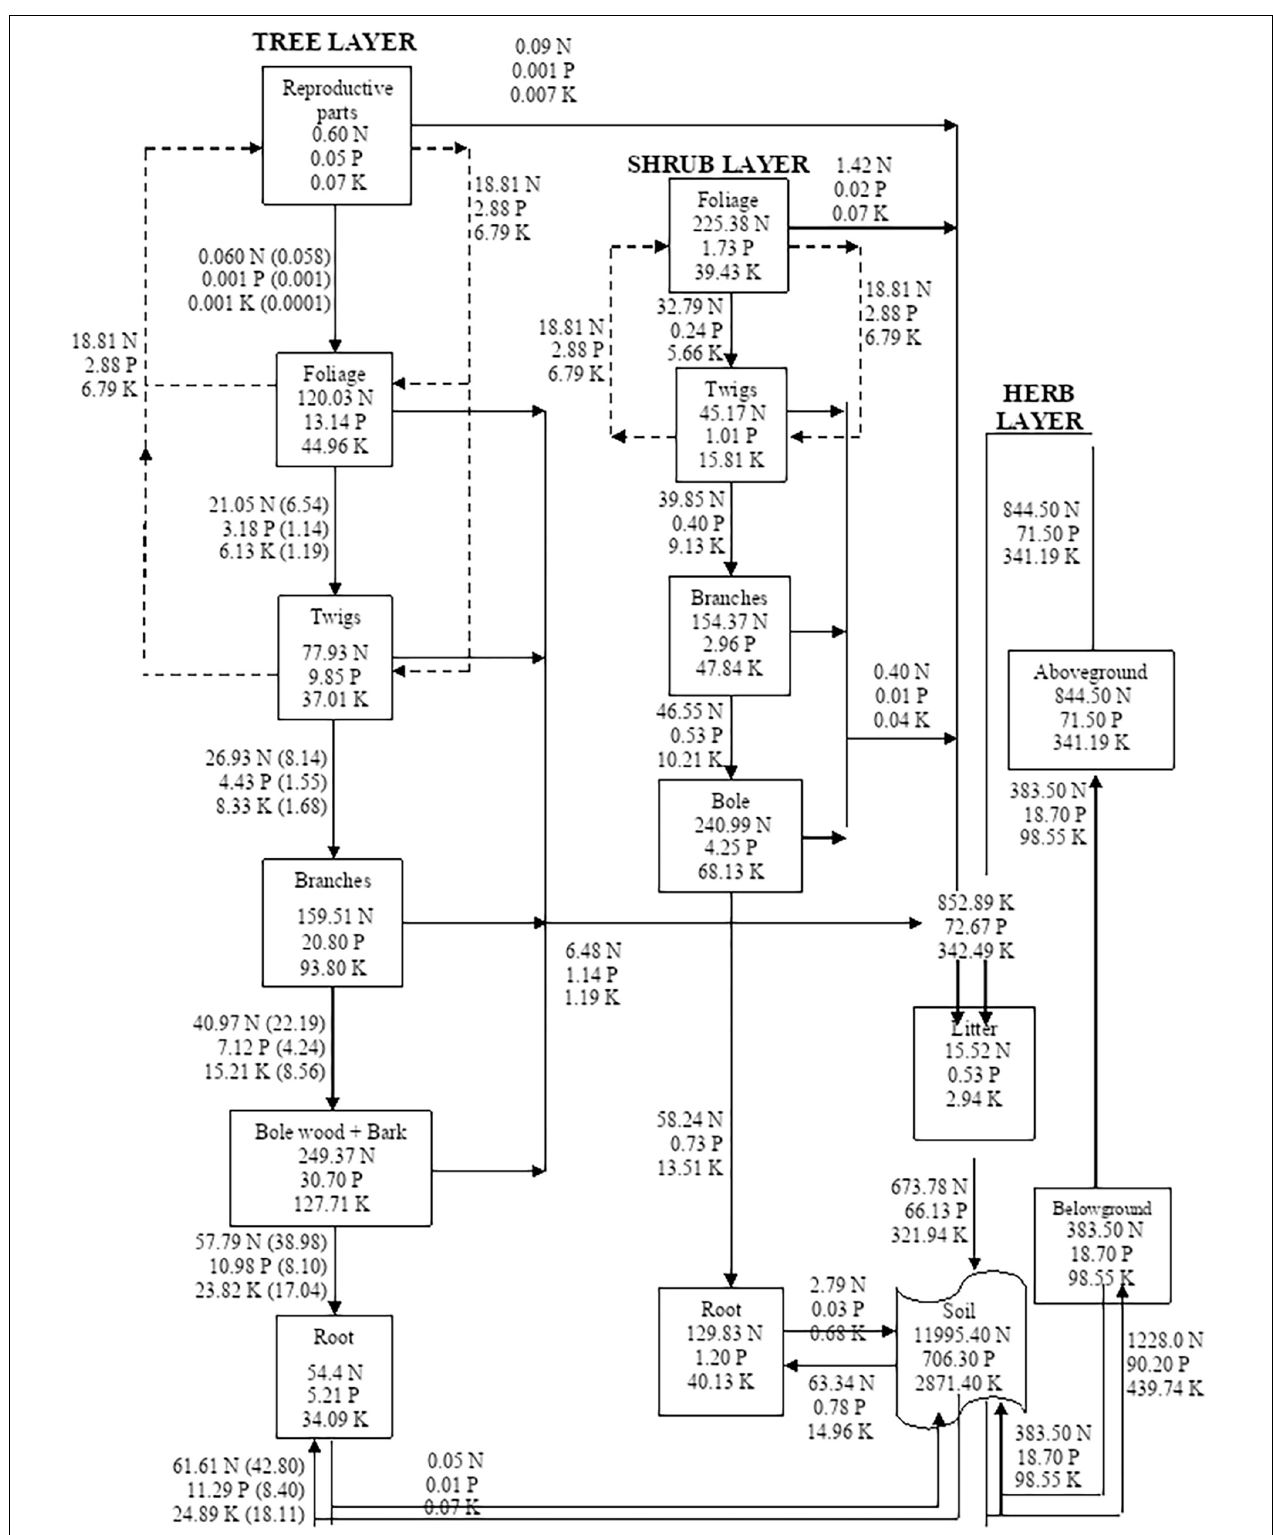
FIGURE 5 | Compartment models showing the distribution and cycling of nitrogen (N), phosphorus (P), and potassium (K) in tree, shrub, and herb at site-5. Rectangles represent compartment for standing state of nutrients from one compartment to the next compartment. Units are kg ha − 1 yr − 1 for flows between compartments. Values in parenthesis are after adjustment for internal cycling. Recycling between reproductive parts, foliage, twigs, and bole is shown by dotted lines.